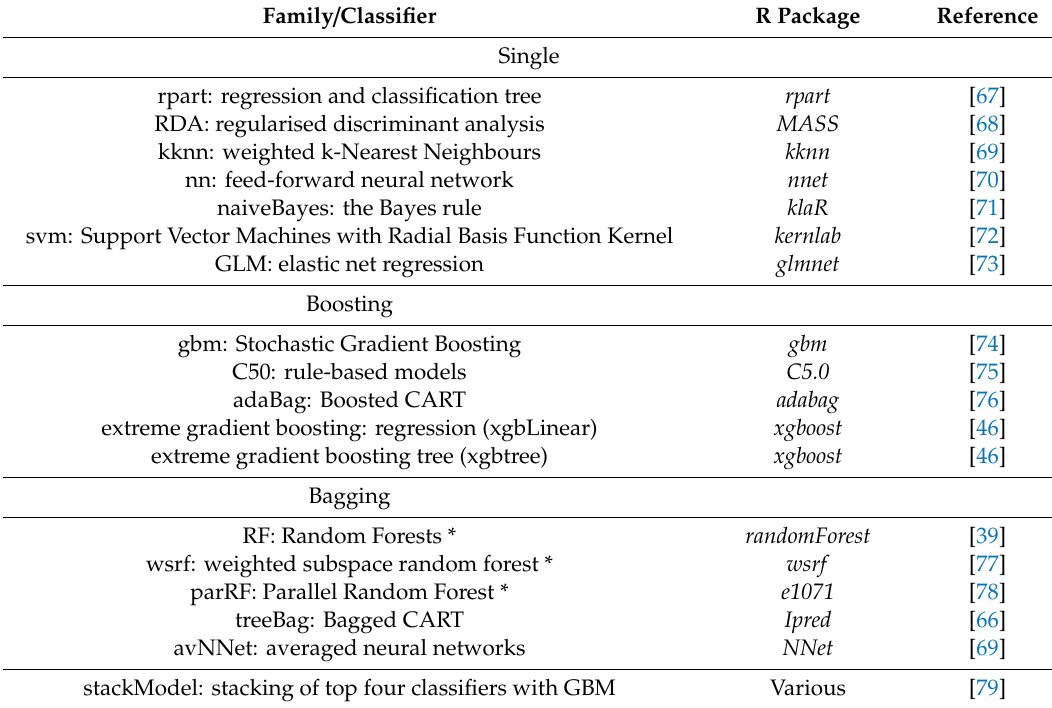
Table 1. The 18 classifiers evaluated in this